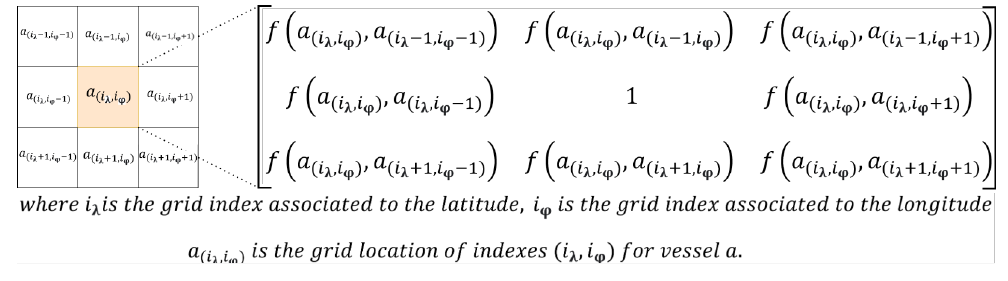
Figure 12. Trained leap rate matrix for vessel a, for the grid rectangle of coordinate indices ( i ϕ , i δ )